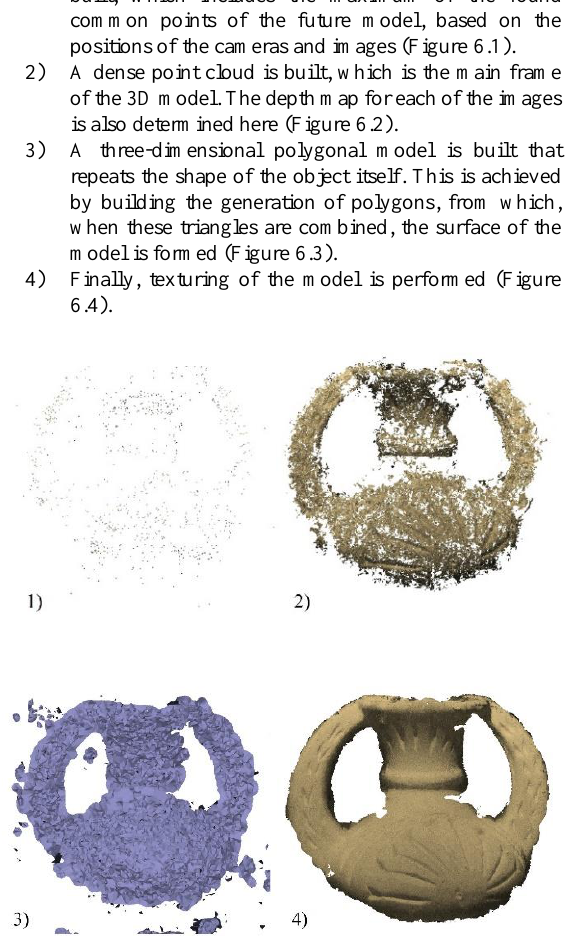
Figure 6. Stages of building the model from hologram: point cloud (1), dense point cloud (2), solid polygonal model (3), and textured model